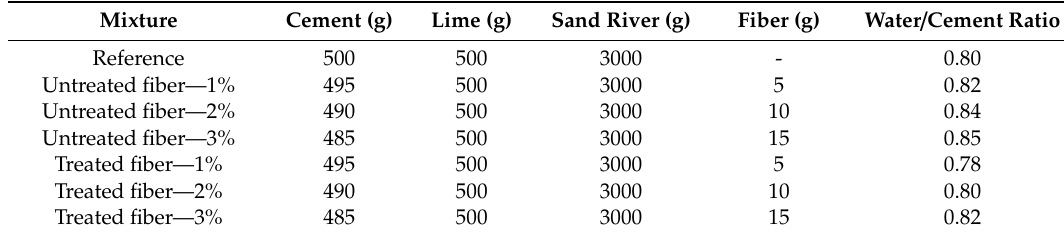
Table 1. Composition of mortar